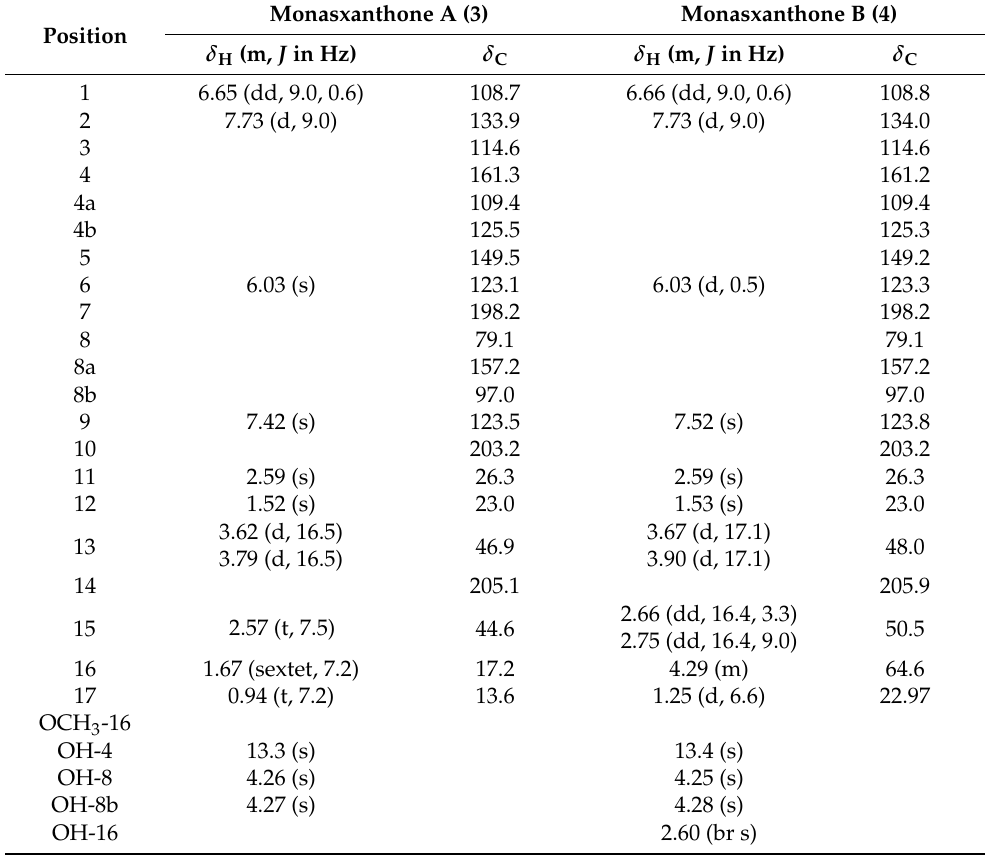
Table 1. 1 H (600 MHz) and 13 C (150 MHz) NMR data of monasxanthones A and B ( 3 and 4 ) in CDCl 3